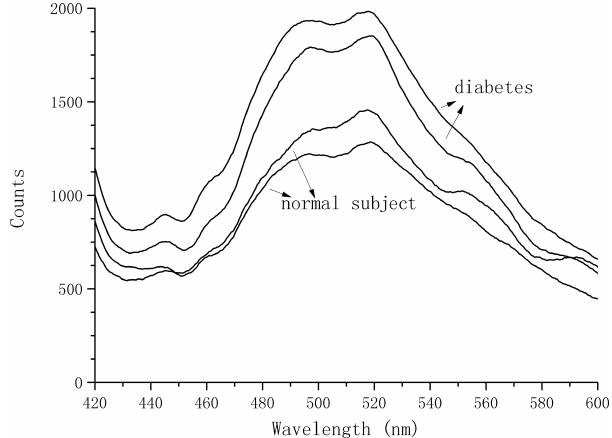
Fig. 1. Typical skin auto°uorescence spectra of the diabetes and control subjects.